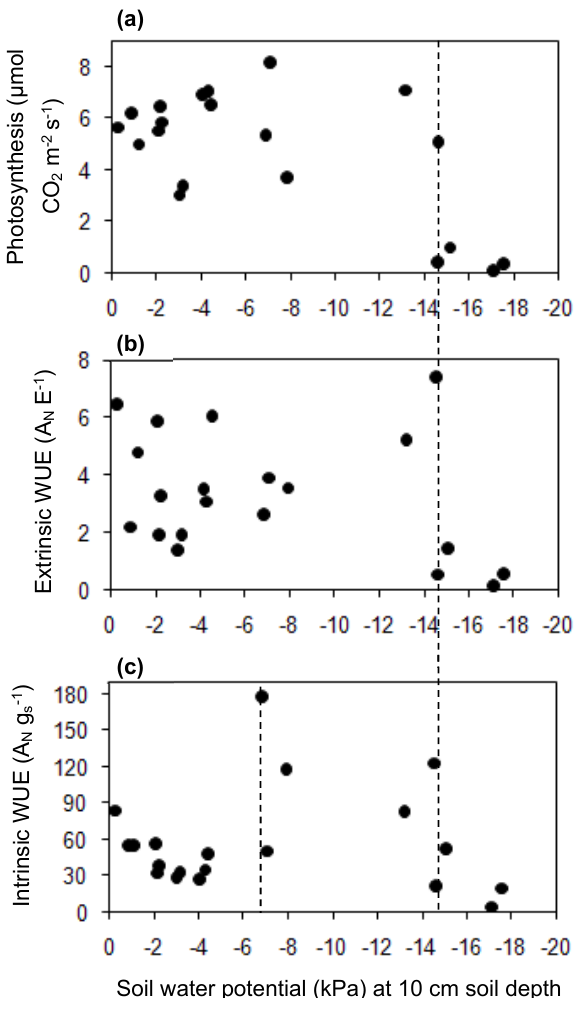
Figure 5. Relationship among average soil water potential (at 0.1 m soil depth) ( n = 6), photosynthesis (A N ) ( n = 3), intrinsic WUE (A N g s − 1 as µmol CO 2 mol H 2 O − 1 ), and extrinsic WUE (A N E − 1 as mmol CO 2 mol H 2 O − 1 ) ( n = 3) of primary leaves of the grapevine in the morning in August, in berry development Stage III. g s : stomatal conductance; E: transpiration.